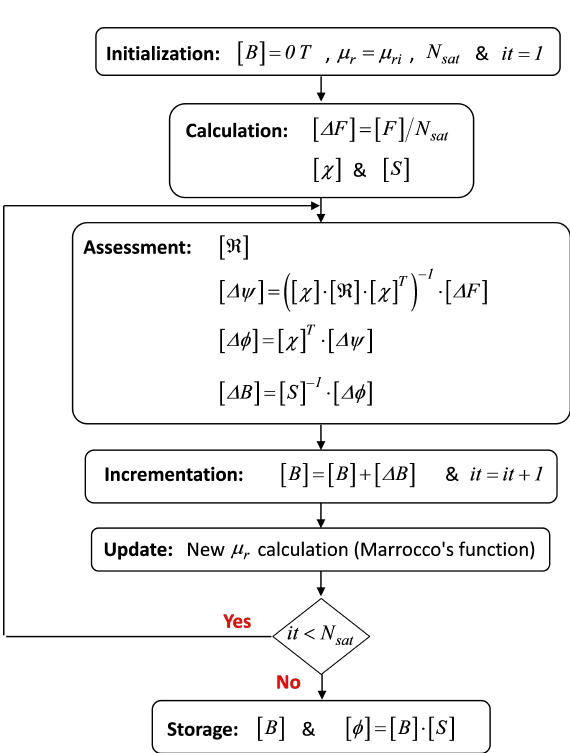
Figure 6. Flowchart of the iterative solving of the nonlinear system